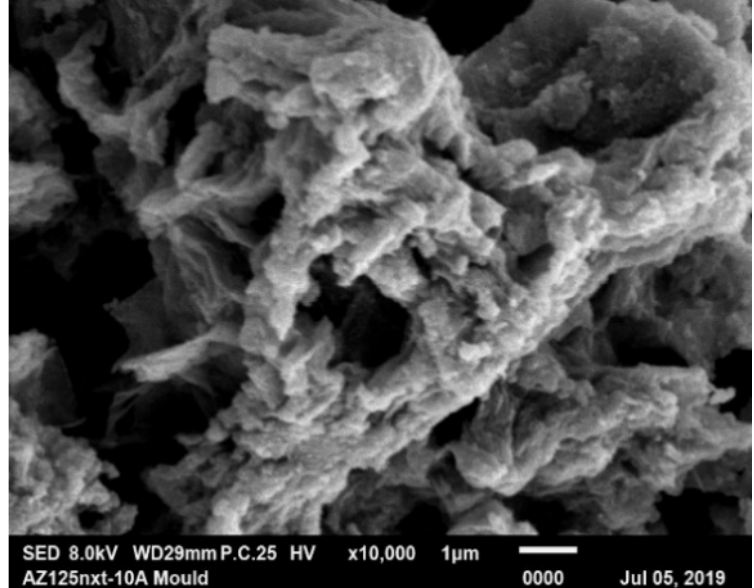
Fig. 4. SEM images of ×10 000 magnification of produced